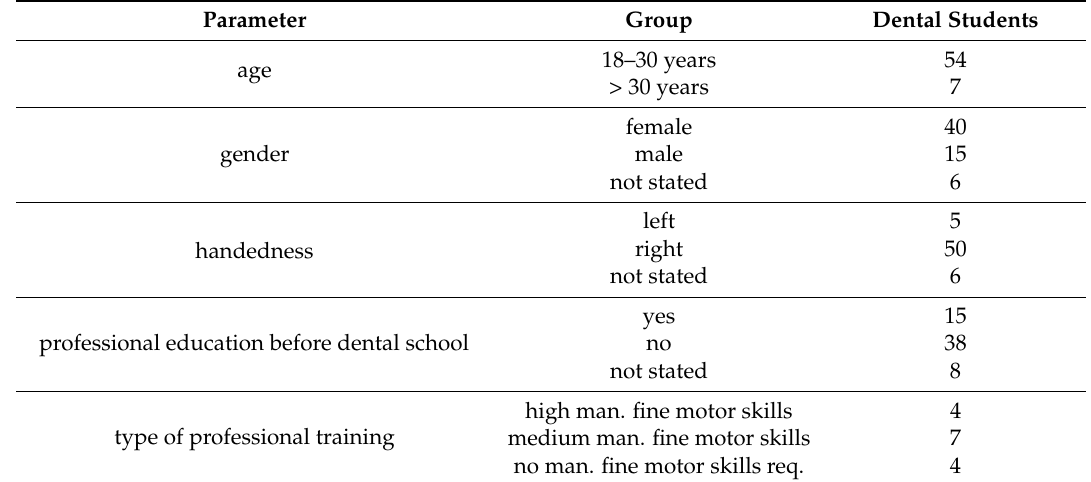
Table 1. Demographical data of the participants in regard to age, gender, and handedness. Furthermore, optionally professional training in the group of the dental students is listed (man.—manual; req.—required). In cases where no specification was made by the student, it was marked as “not stated”. Parameter Group Dental